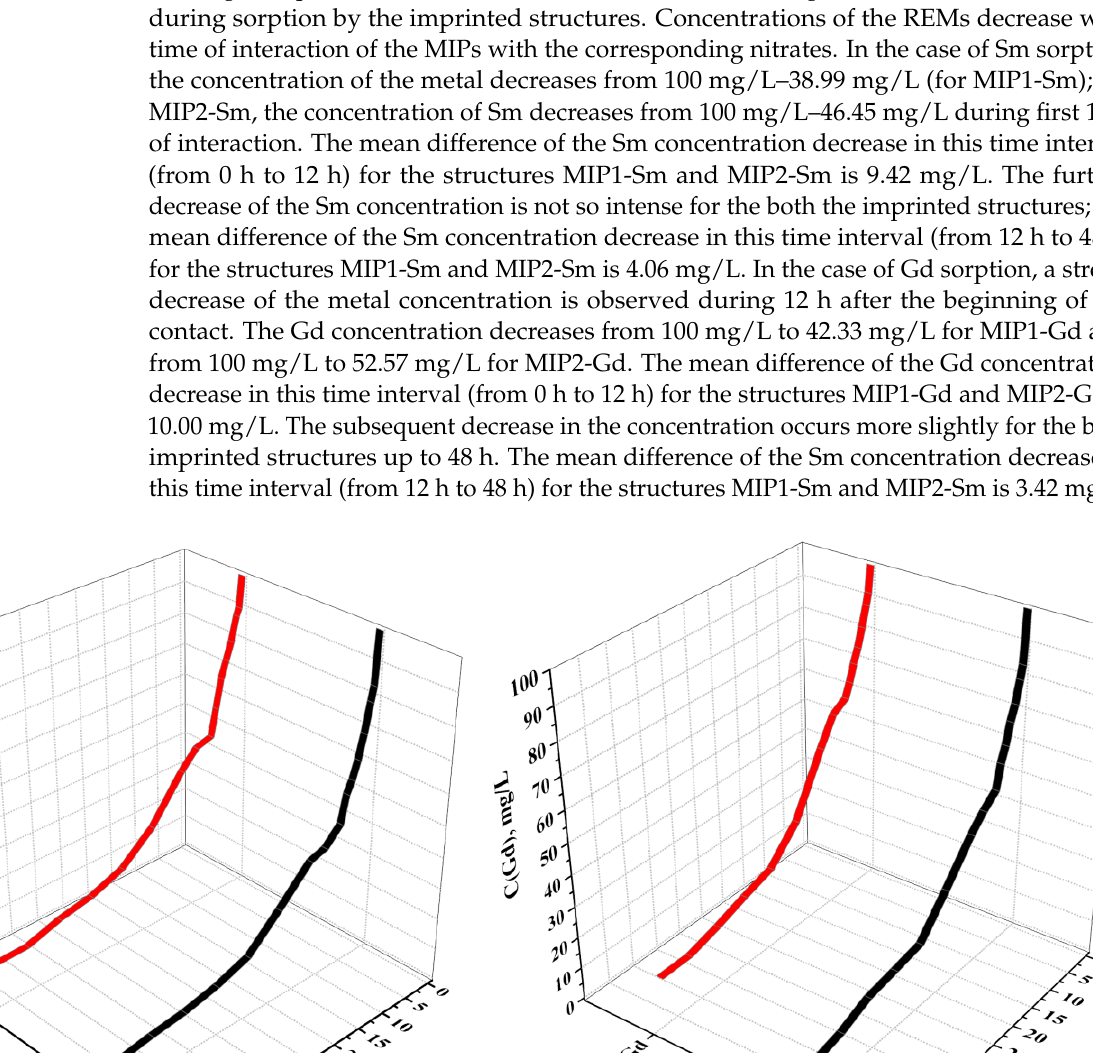
Table 1. Decreasing values of samarium and gadolinium concentrations via imprinted structures MIP1, MIP2.